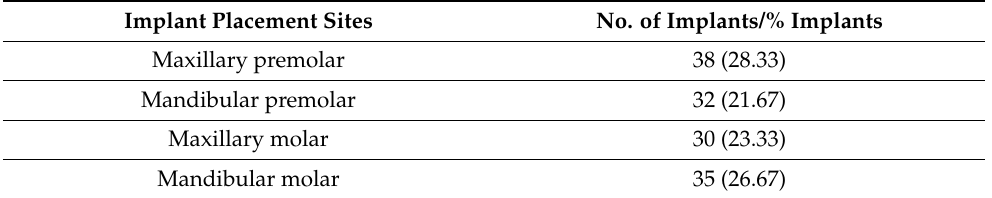
Table 1. Implant placement sites in relation to implants’ number.